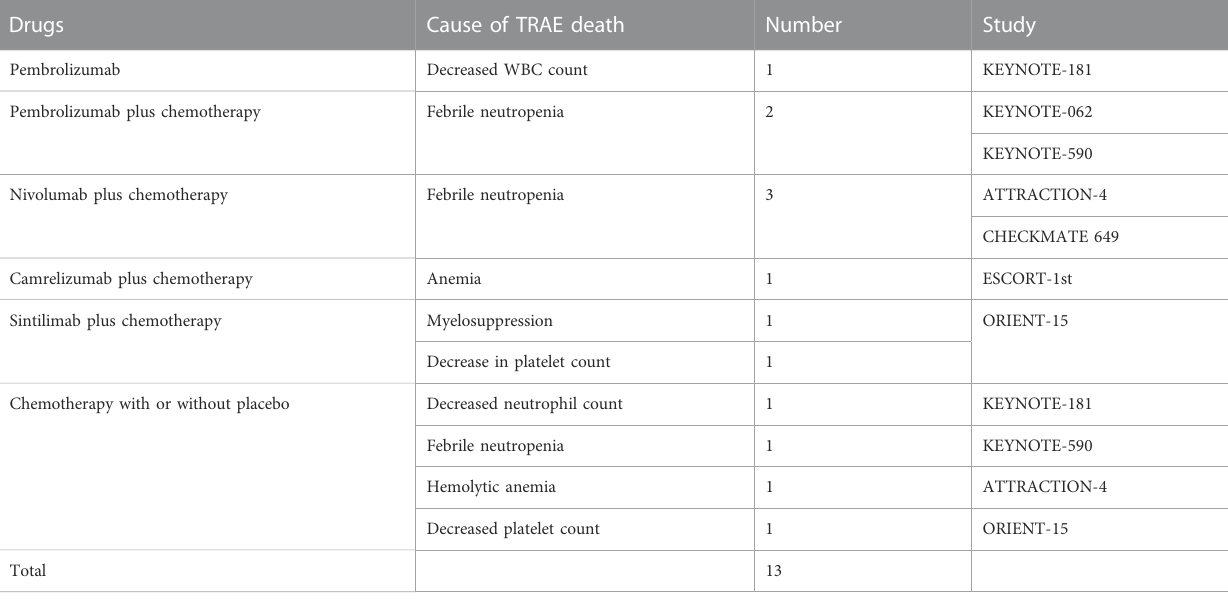
TABLE 2 Cause summary of death due to hematologic adverse events.